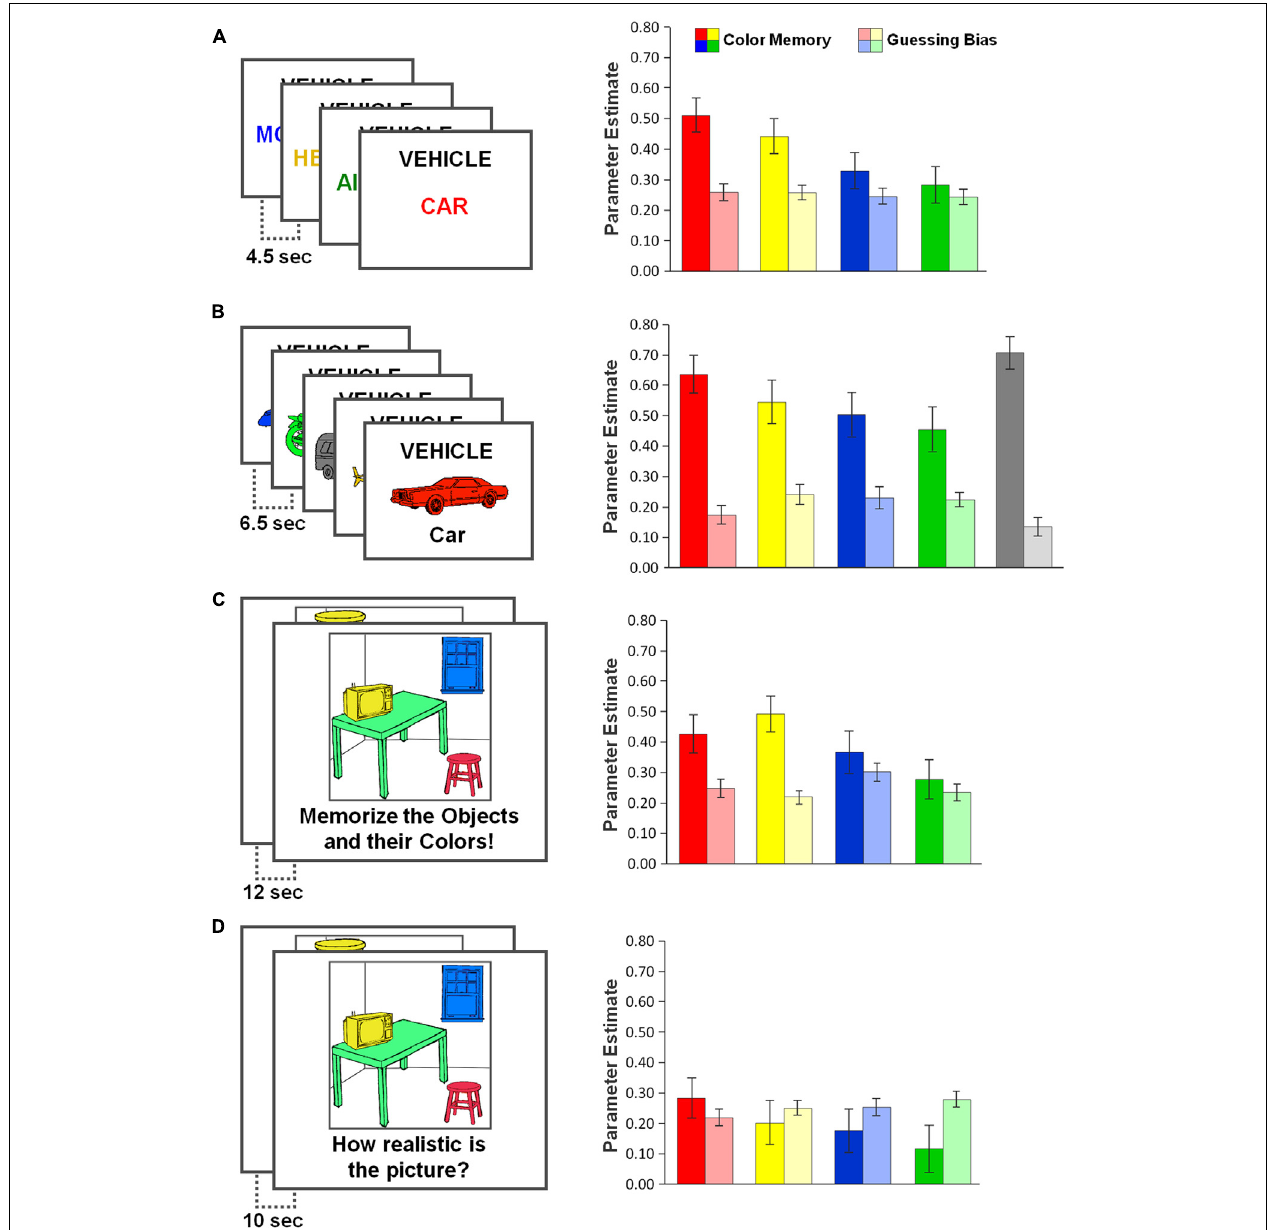
color-specific guessing (i.e., the tendency to respond with a specific color in the absence of memory for an object’s original color). Parameters were estimated using the multinomial model shown in Figure 2 . Error bars represent 95 % confidence intervals of the parameter